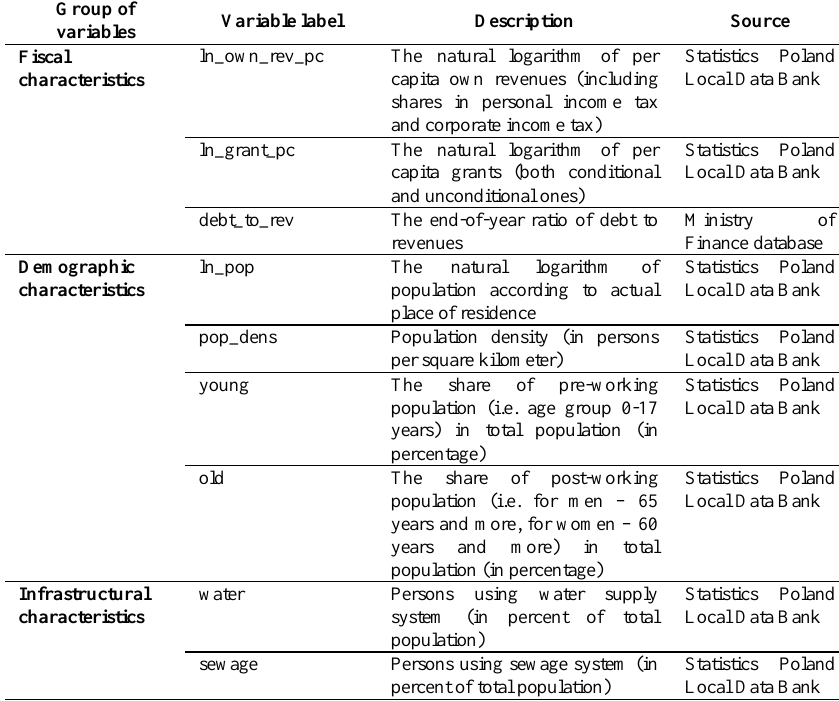
Table 1. Explanatory variables description and data sources